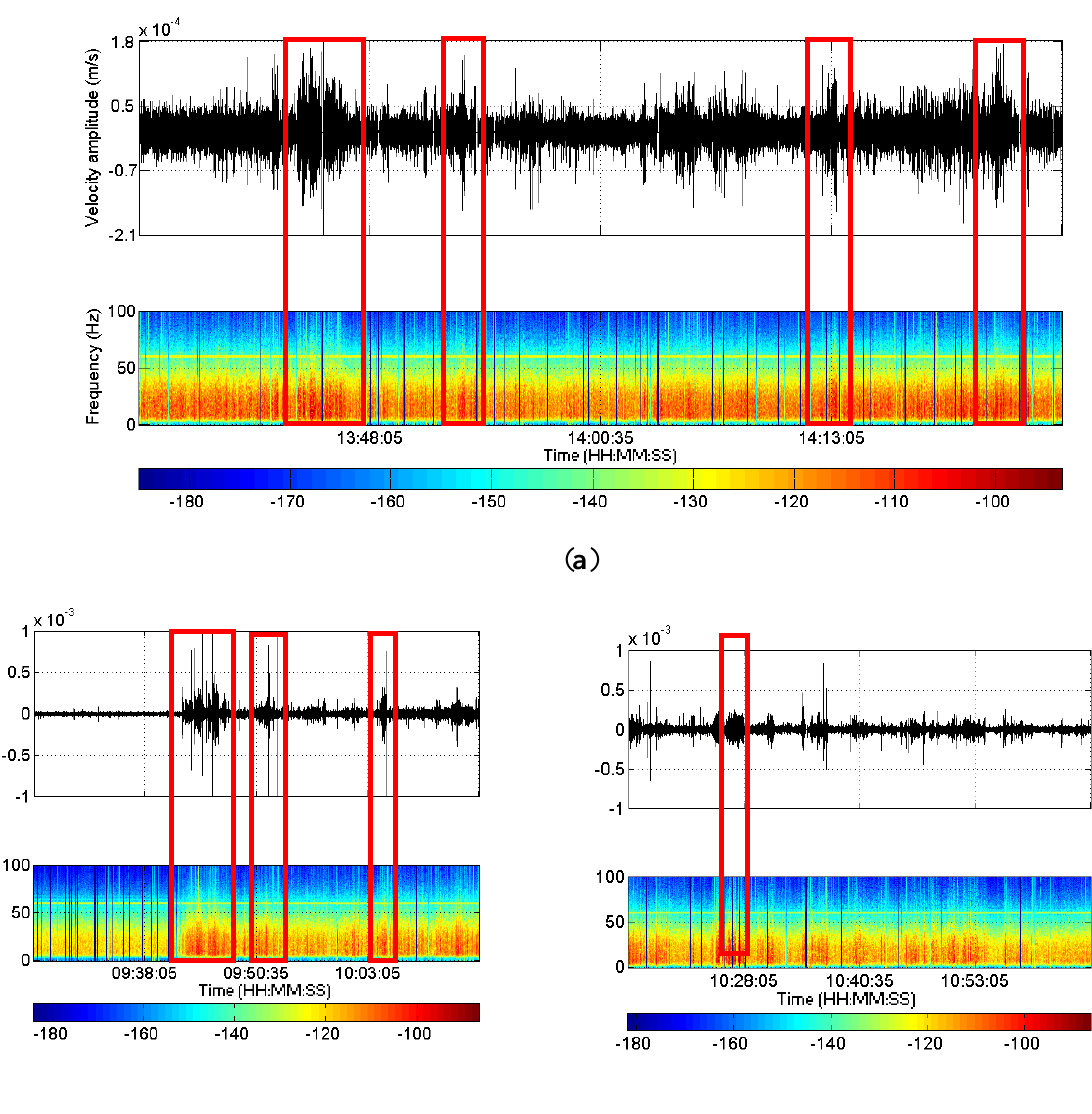
rectangles). Upper part: stacking of the amplitudes of the vertical components. The plot has been re-filtered with a band-pass between 5‒40 Hz to reduce electrical noise and better visualize the frequency change. Lower part: Spectrograms for the same time period; ( b ) Similar signals to microseismic events (framed by red rectangles). Upper part: Stack of the amplitudes for the vertical components of every geophone (100 min time window). Lower part: Spectral density stacking for the vertical components of every